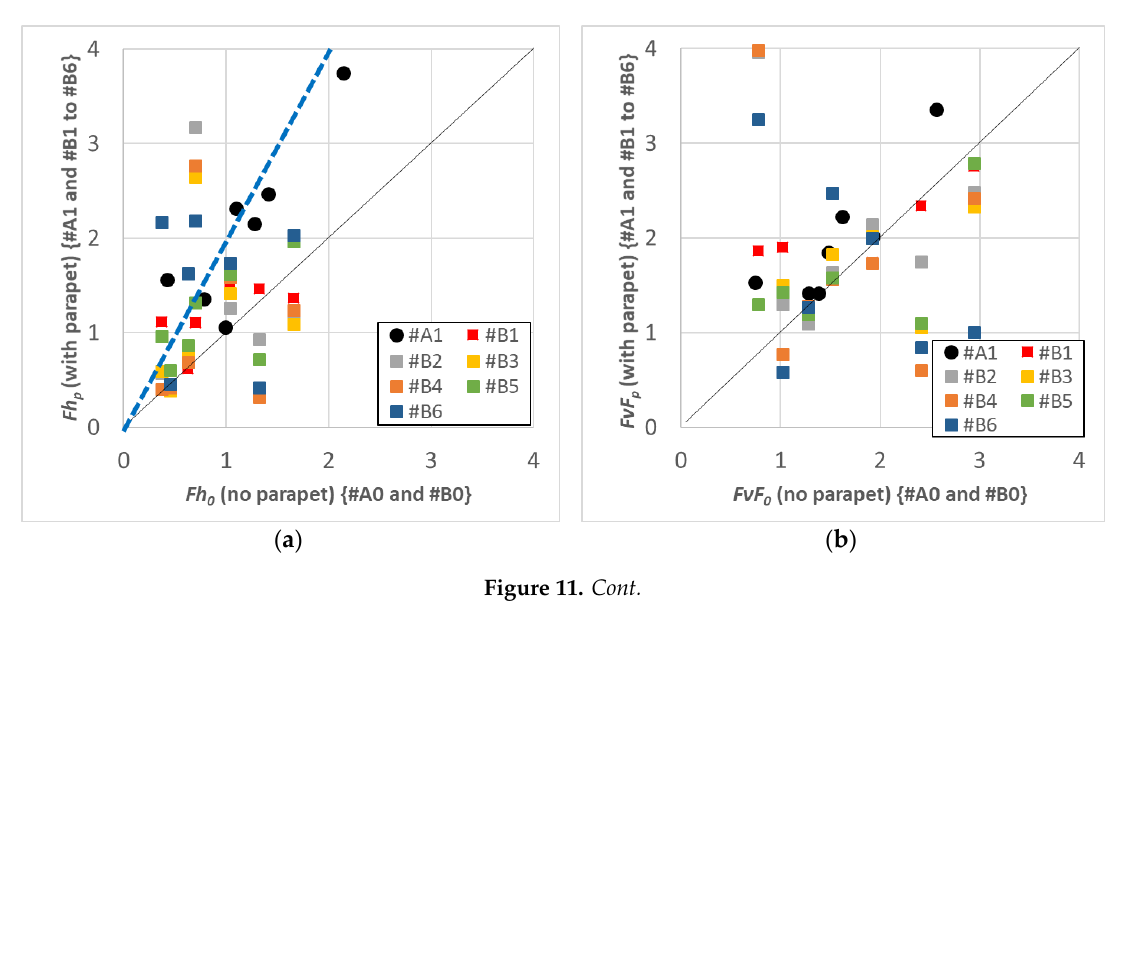
Figure 10. Comparison of pressure field and velocity components. Simulation of 180 s of testing with H m0i = 0.14 m and T p = 3 s, and models #B0 and #B2.